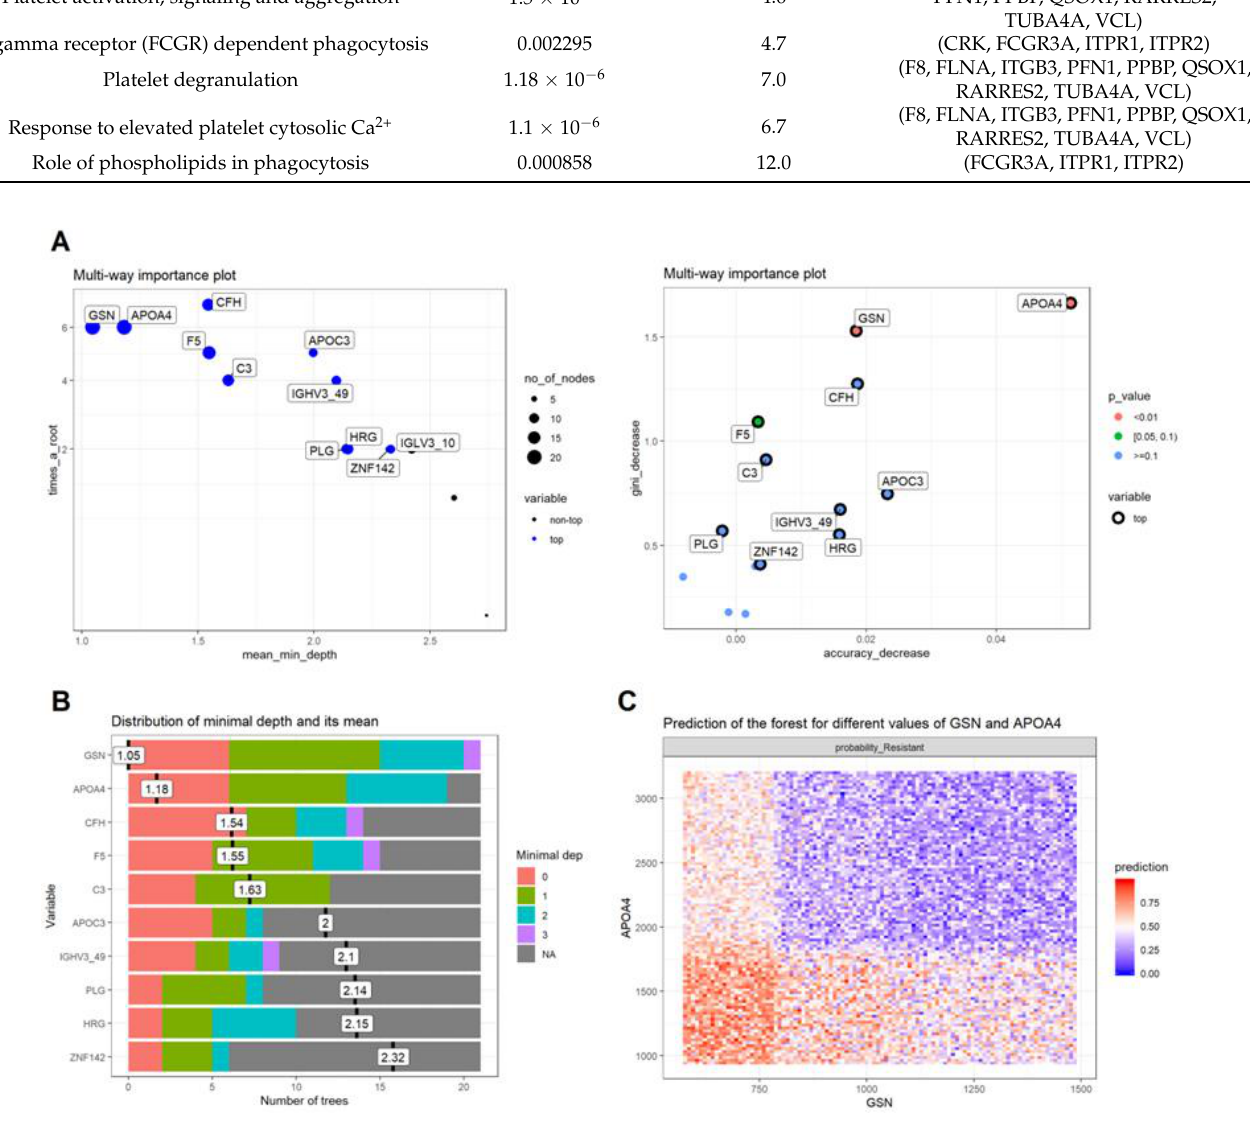
Figure 2. Variable importance for the 14 proteins used to train the random forest classifier so as to distinguish between responders (hypersensitive) and non-responders (resistant) to cortisol: ( A ) Multiway importance plots depicting the mean decrease in accuracy as a function of the mean minimal depth (left) and of the mean decrease in the Gini index (right); ( B ) Plot showing structure of the forest with respect to the distribution of the mean minimal depth across trees for each variable; ( C ) Predictive value of the top two important variables (APOA4 and GSN) in detecting non-responders, based on their normalized protein intensity areas across samples.